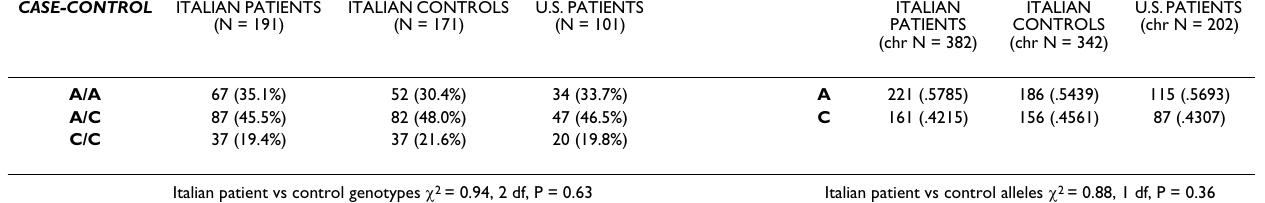
Table 5: Case-control, TDT and FBAT (additive model) analyses of SNP C419A (A111E) at the GLO1 locus. CASE-CONTROL ITALIAN PATIENTS ITALIAN CONTROLS (N = 191) (N = 171)